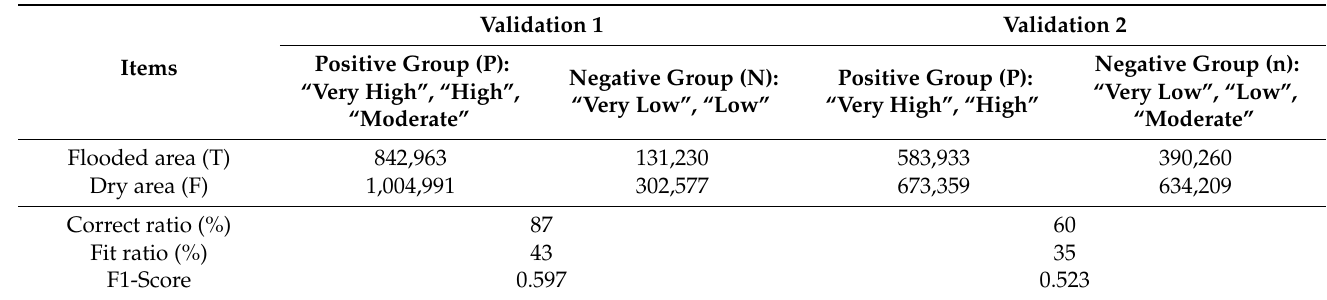
Table 6. The comparison matrix and correct ratio, fit ratio, F1-score of flood hazard and flooded areas